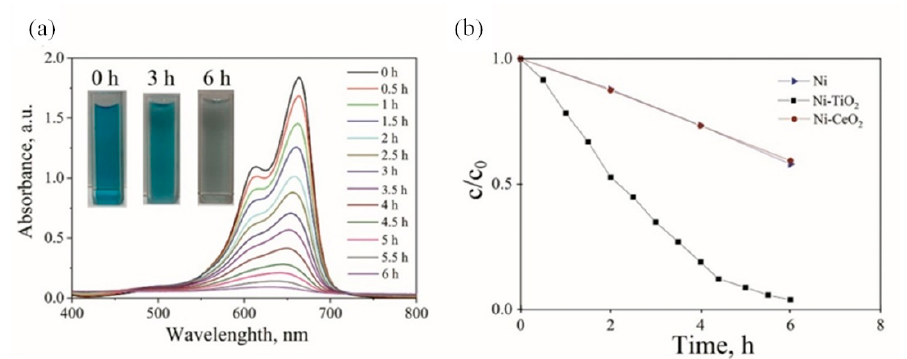
Figure 14. UV-Vis spectra of Ni-TiO 2 in MB aqueous solution ( a ); Photocatalytic degradation of MB at Ni, Ni-CeO 2 , Ni-TiO 2 ( b ).